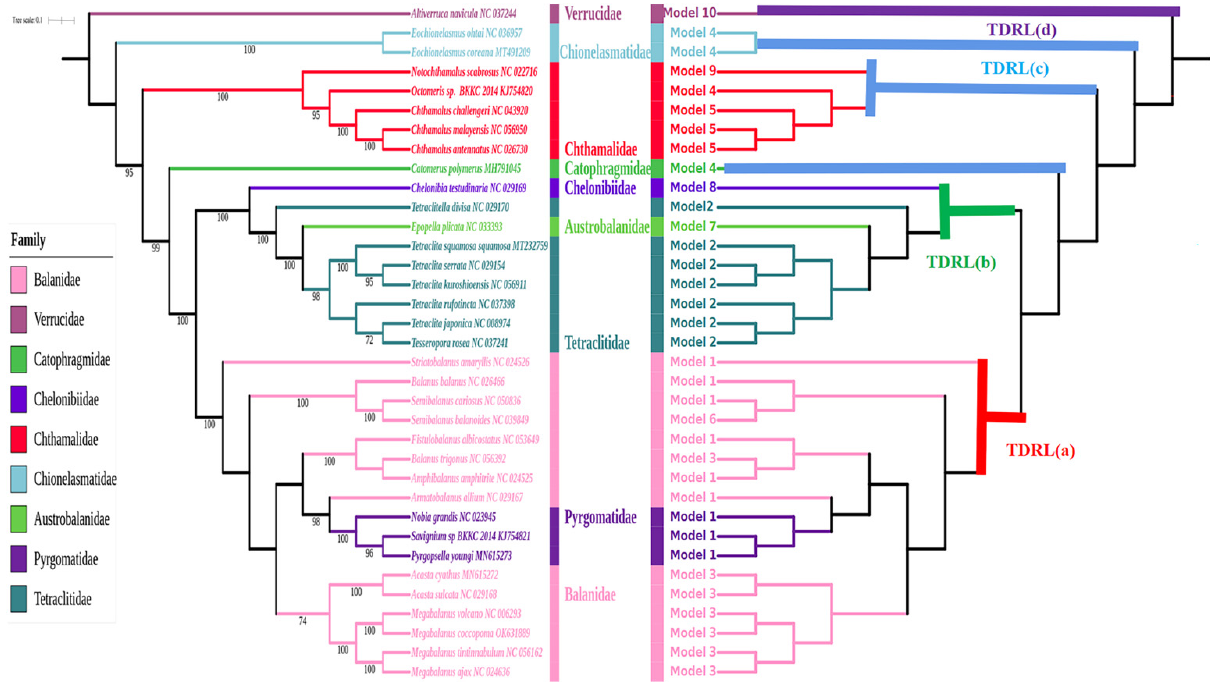
Figure 4. The IQ-Tree is based on 13 PCGs nucleotide sequences of M. coccopoma and other mito- chondrial genomes from 35 barnacles. The numbers at the nodes represent the bootstrap values derived from ML analysis. The IQ-TREE will disregard inverted branch lengths, and TDRL events will be omitted.